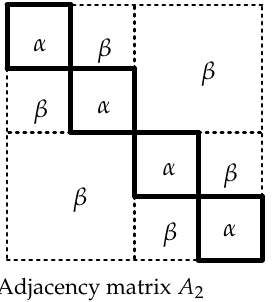
Figure 9. Benchmark graph. Model 2.